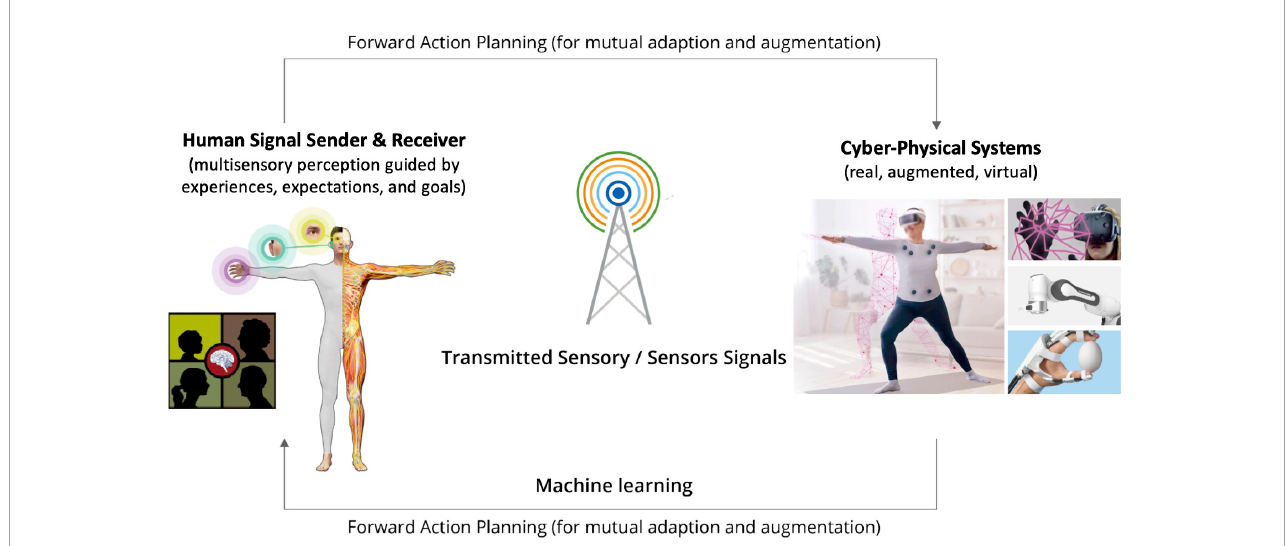
FIGURE1 Schematic diagram of digitally transmitted closed-loop perceptual and cognitive interactions between humans and cyber physical systems (CPS) supported by Tactile Internet (TI) technologies [parts of the image are adapted from the authors’ work, Li et al., 2021, Copyright Elsevier 2021; the image of the senior female is a modification of royalty-free content with usage licence, credit: